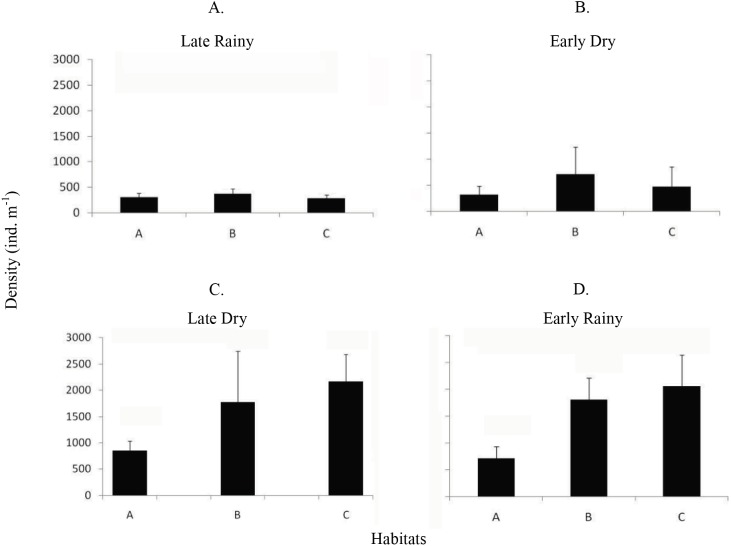
Density of A. flexuosa.Average and standard deviations density of Anomalocardia flexuosa (ind m−1) at a three different habitats (habitats A, B, C) of the tidal plain of the Goiana estuary along different seasons. (A) Late Rainy; (B) Early Dry; (C) Late Dry; (D) Early Rainy.